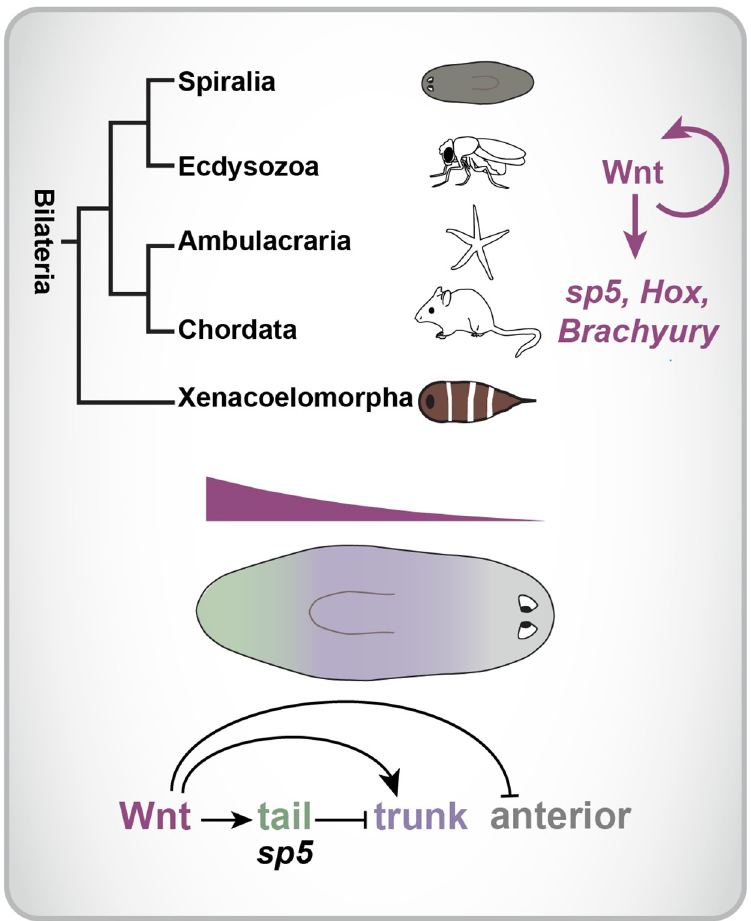
Fig 9. Model. We propose that a common Wnt-dependent program including sp5 , posterior Hox genes, Brachyury , and Wnt-pathway components was active in the posterior of the bilaterian ancestor. In planarians, sp5 acts to pattern the primary axis through inhibition of Wnt-dependent trunk gene expression in the